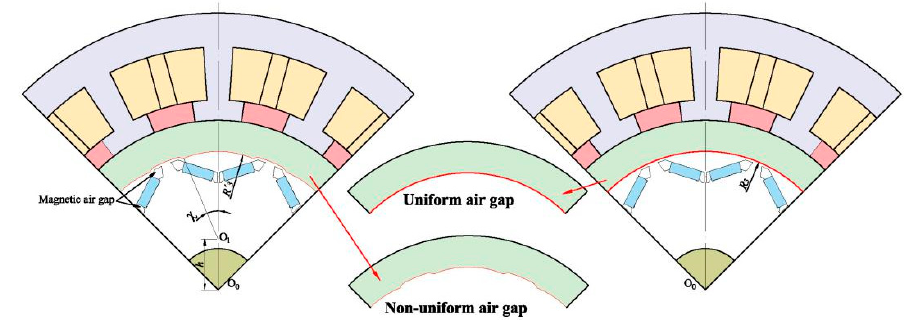
Figure 6. Schematic diagram of non-uniform air gap.